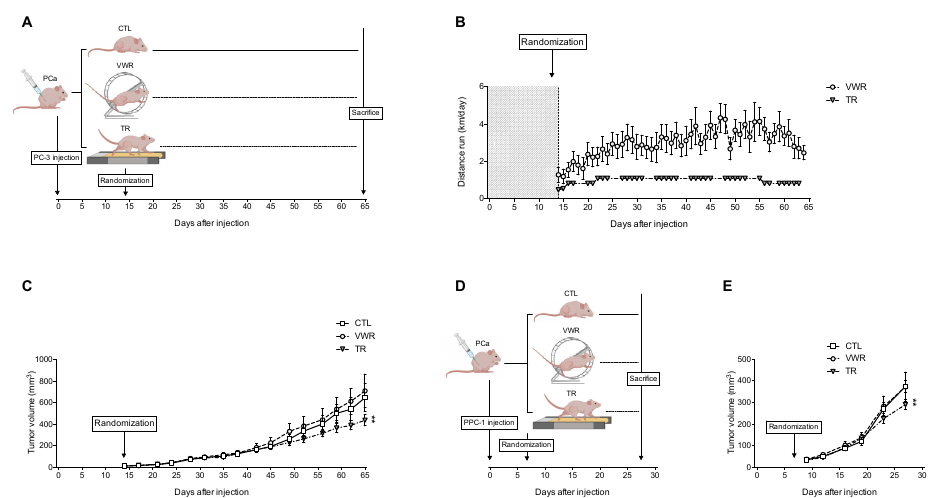
Figure 6. TR slows down tumor growth in both PC-3 and PPC-1 xenografts, while VWR has no effect. ( A ) Experimental design with PC-3 xenografts; ( B ) Distance ran (km/day) throughout the protocol by VWR and TR mice; ( C ) Tumor volume (in mm 3 ) evolution in PC-3 xenografts; ( D ) Experimental design with PPC-1 xenografts; ( E ) Tumor volume (in mm 3 ) evolution in PPC-1 xenografts. Data are represented as means ± SEM. ** p < 0.01.